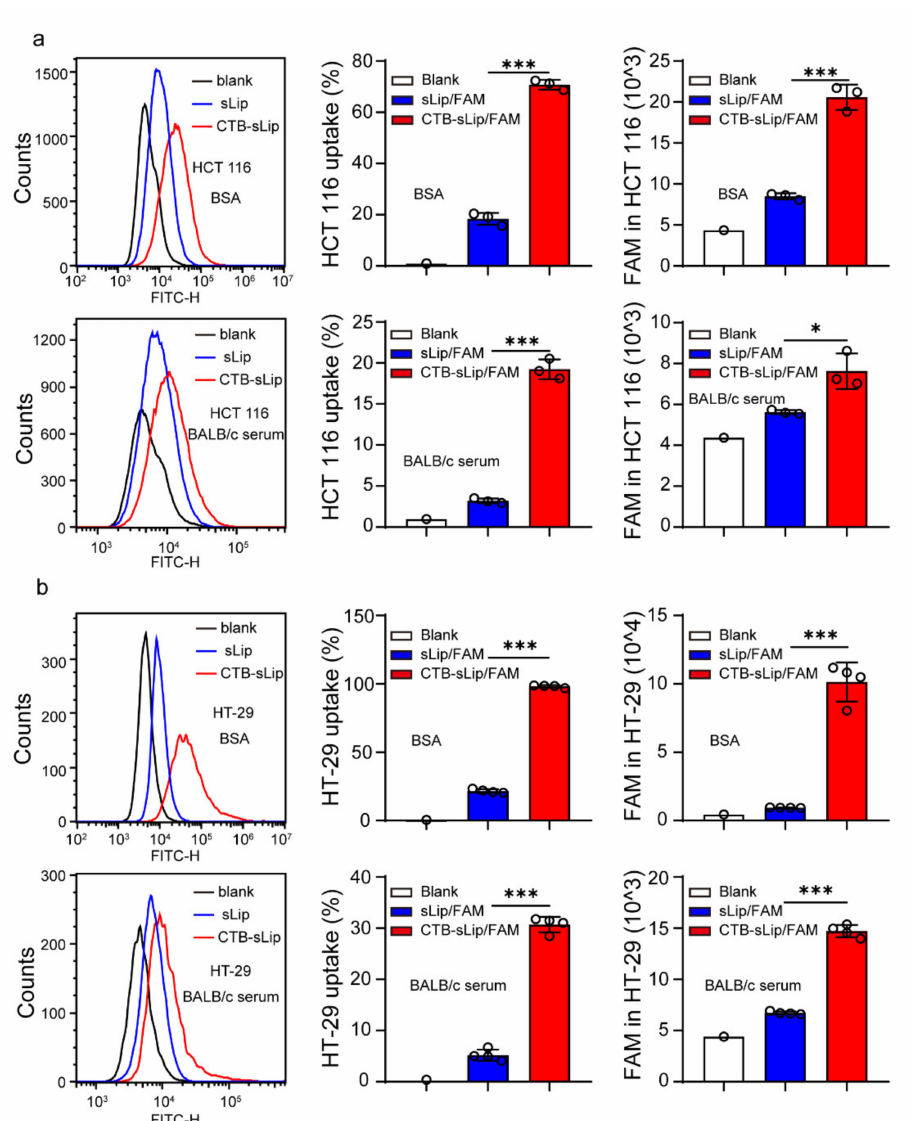
Figure 4. Effect of BALB/c serum on the targeting capability of CTB-sLip to human-derived colorectal cancer cells. CTB-sLip/FAM (5 µ M 5-FAM) were prepared to study the in vitro uptake by HCT116 cell (( a ), n = 3) and HT-29 cell (( b ), n = 4) at 37 ◦ C after 2 h incubation, in 0.1% BSA and 10% BALB/c serum, respectively. Data are means ± SDs. * p < 0.05 and *** p < 0.001 based on one-way ANOVA with